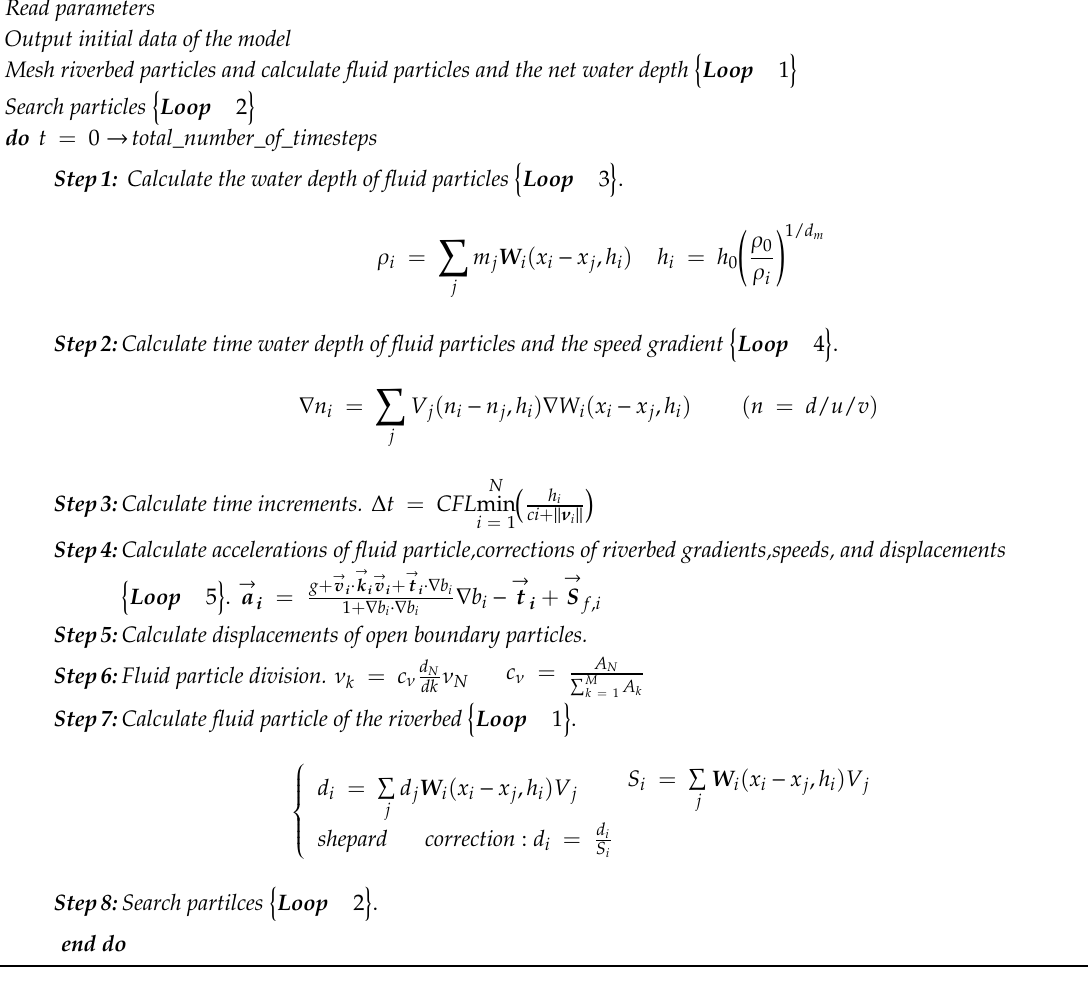
Algorithm 1. Calculation framework of the SPH-SWEs model. This algorithm is needed to read the particles data (include fluid particles / virtual particles / open boundary particle / riverbed particles). Read